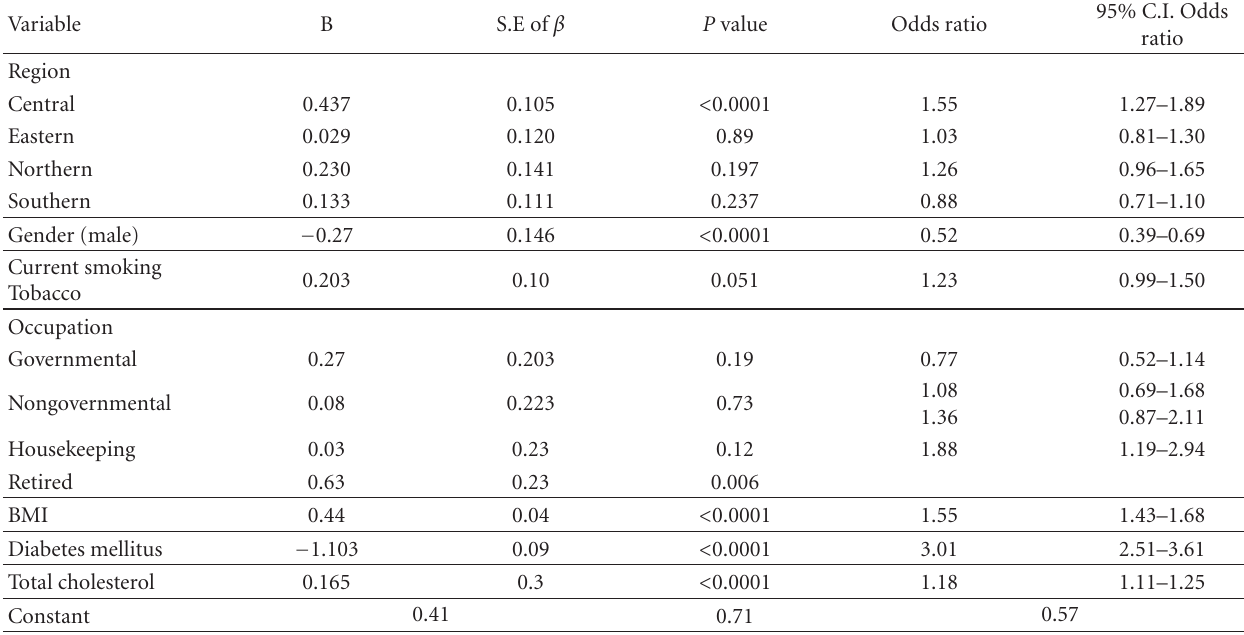
Table 3: Logistic regression model to predict hypertension from some studied variables adjusting for